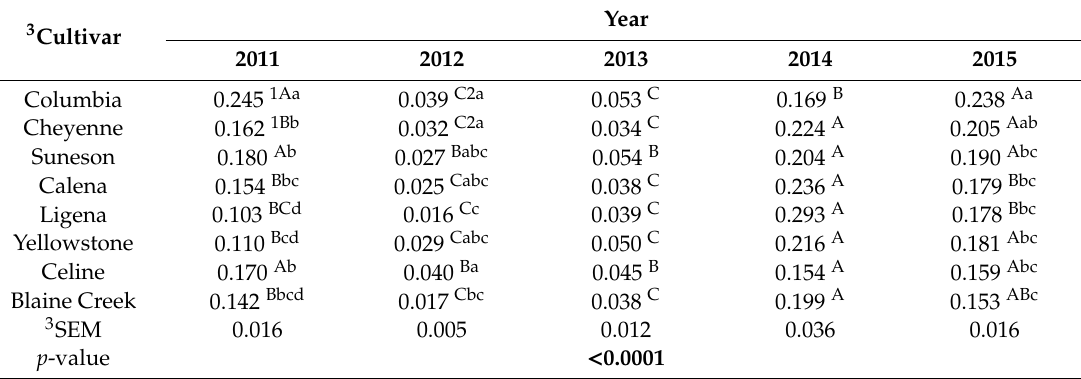
Table 6. Interaction e ff ect of cultivar × year on harvest index (kg kg − 1 ) of eight C. sativa cultivars grown during the spring growing season of 2011 to 2015 in Reno, Nevada,